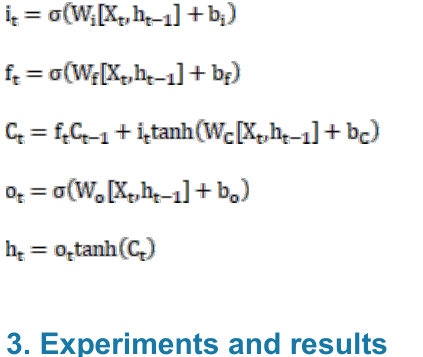
Table 1. Input dataset for training and